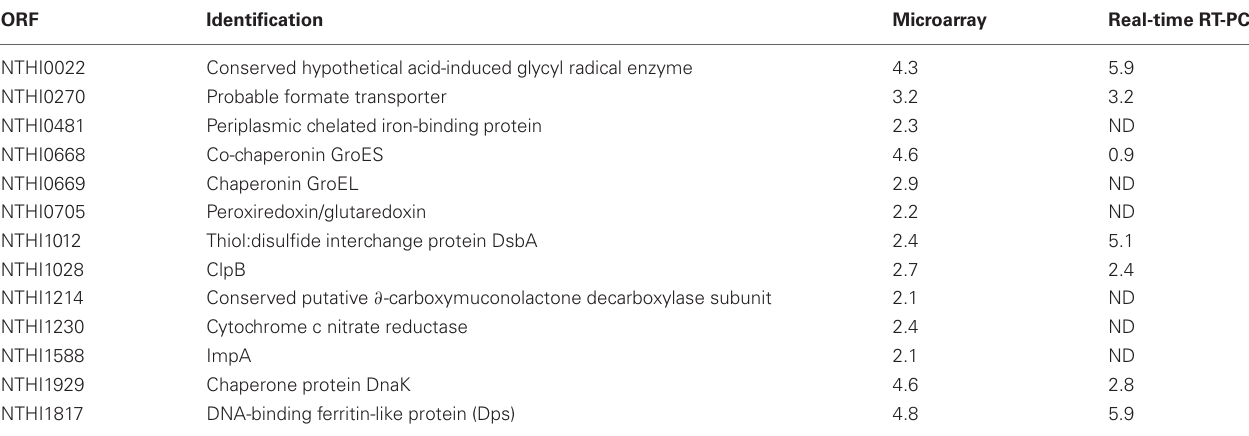
Table 2 | Transcripts with increased expression in NTHi 86-028NP